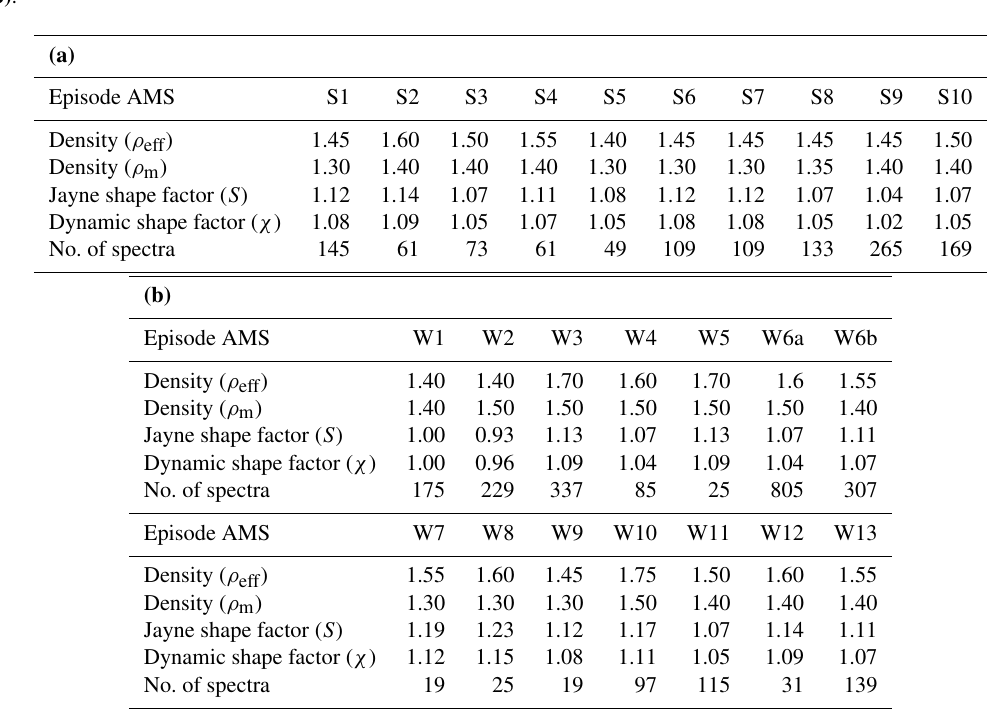
Figure 7. Diurnal trends of average ρ m calculated based on Eq. (2) in the main text from Salcedo et al. (2006) in summer (a) and winter (b) . Table 4. Particle densities (gcm − 3 ) and shape factors calculated during episodes of high mass concentrations using AMS data in summer (a) and winter (b)